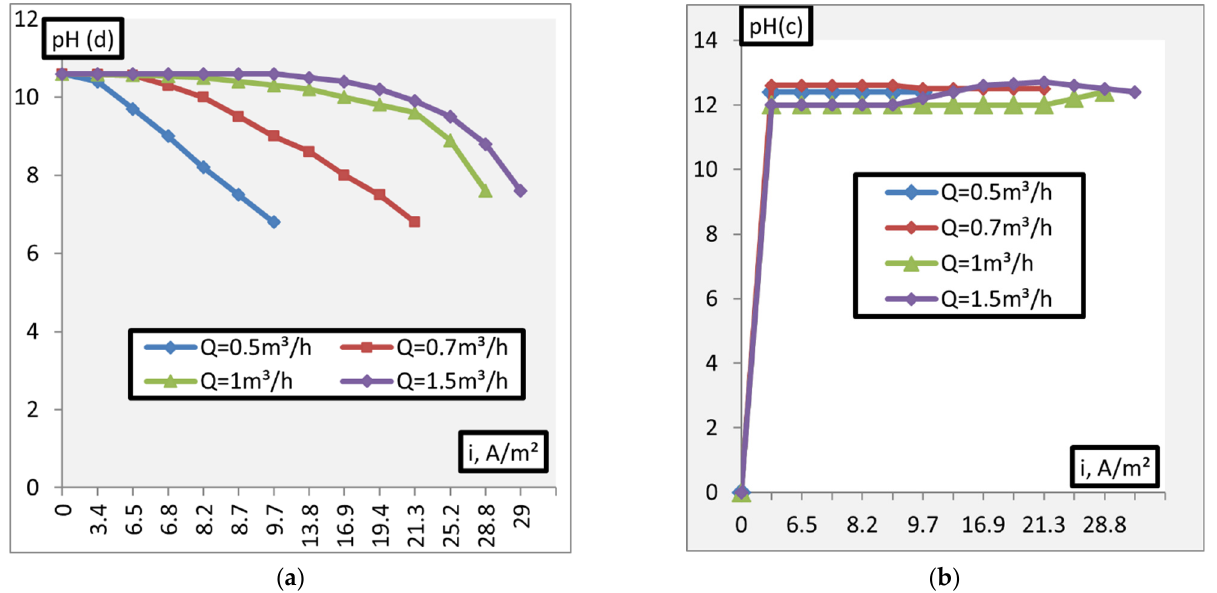
Figure 9. Dependence of the pH. (( a )—pH(d), ( b )—pH(c)) adjustment of alkaline solutions on the current density and process performance (initial pH = 10.6).